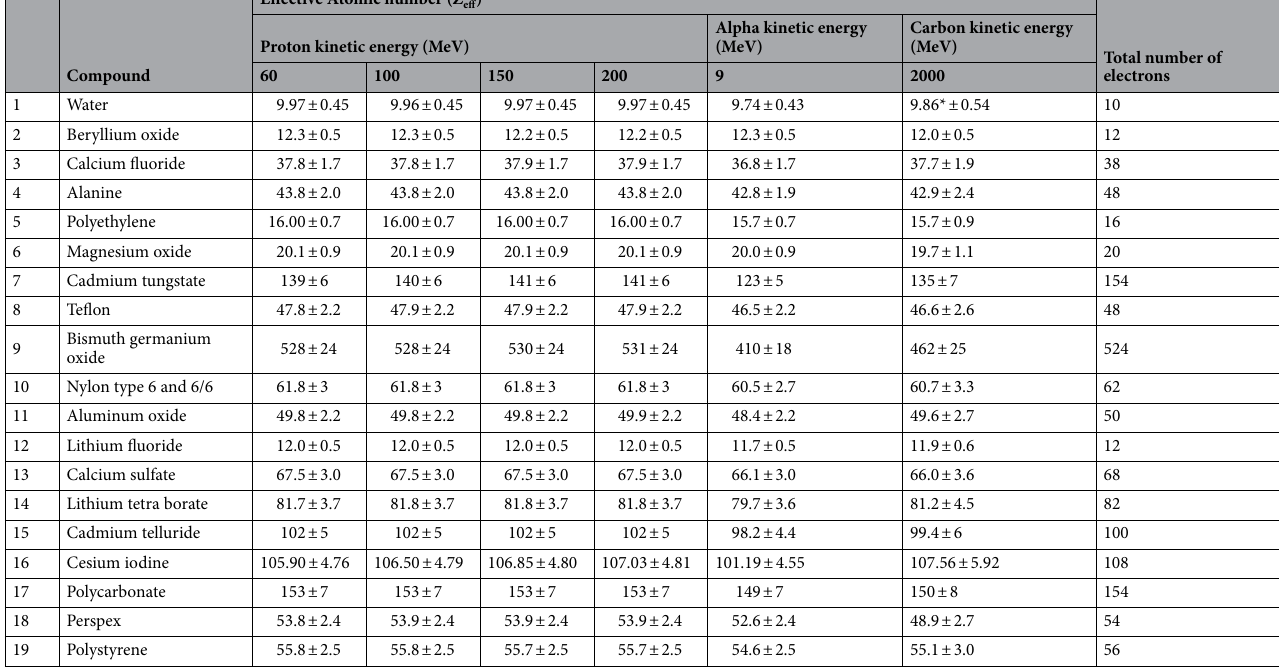
Table 5. Results of effective atomic number in a few of kinetic energies for different compounds using collisional stopping power of proton, alpha, and carbon. The uncertainties are due to the uncertainty of the stopping powers in the SRIM code. *The effective atomic number of water for carbon ions with kinetic energy of 4.6 GeV is calculated 9.81. It should be mentioned that 4.6 GeV carbons and 200 MeV protons have the same range in